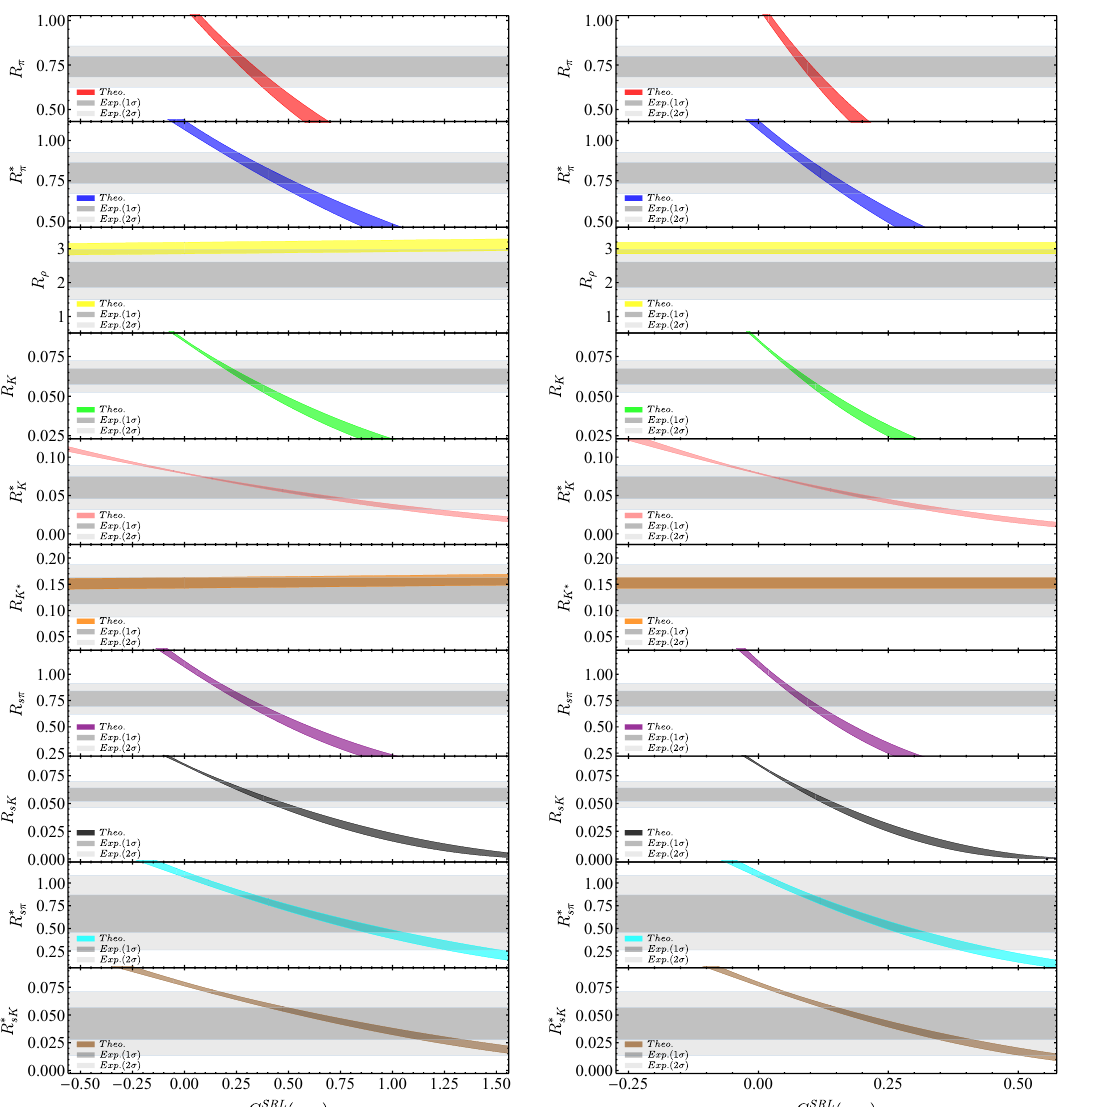
Figure 12 . Constraints on the NP Wilson coefficients C SRL